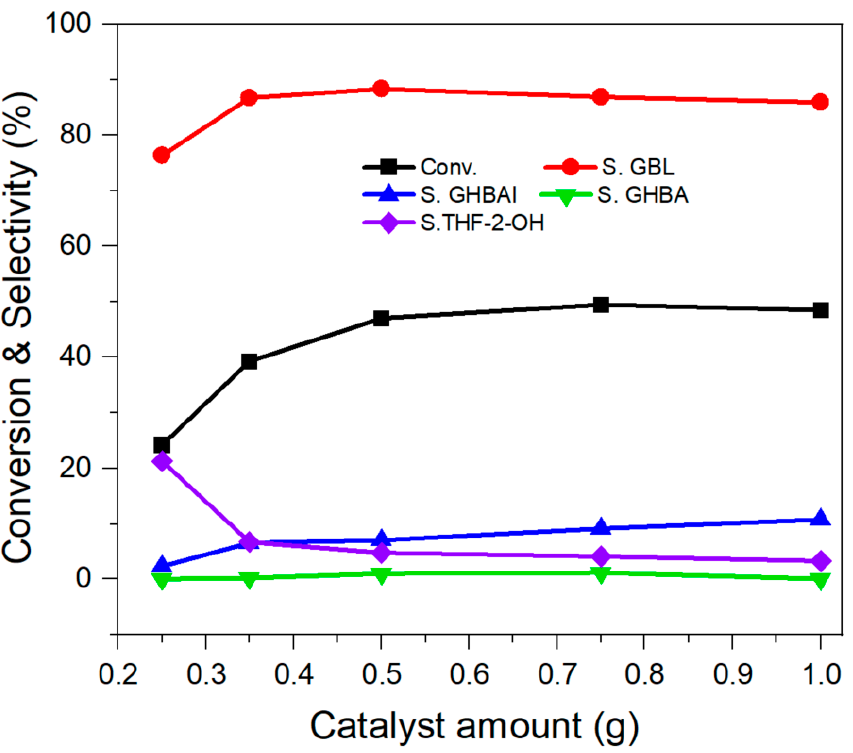
Figure 12. Effect of ZFNPs amount on the conversion and selectivity for the oxidation of THT. Reaction conditions: H 2 O 2 = 0.1 mol, THF = 0.1 mol, 80 °C, and 9 h.